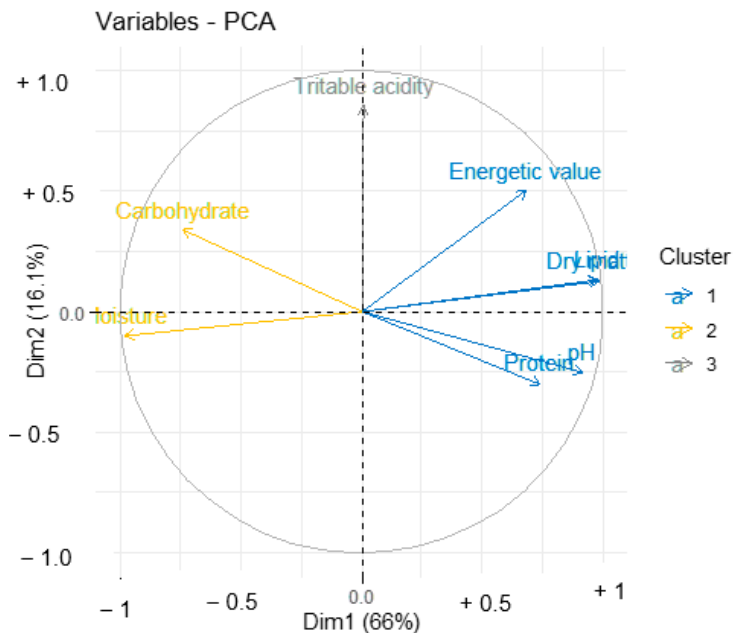
Figure 7. Principal component analysis of biochemical parameters.